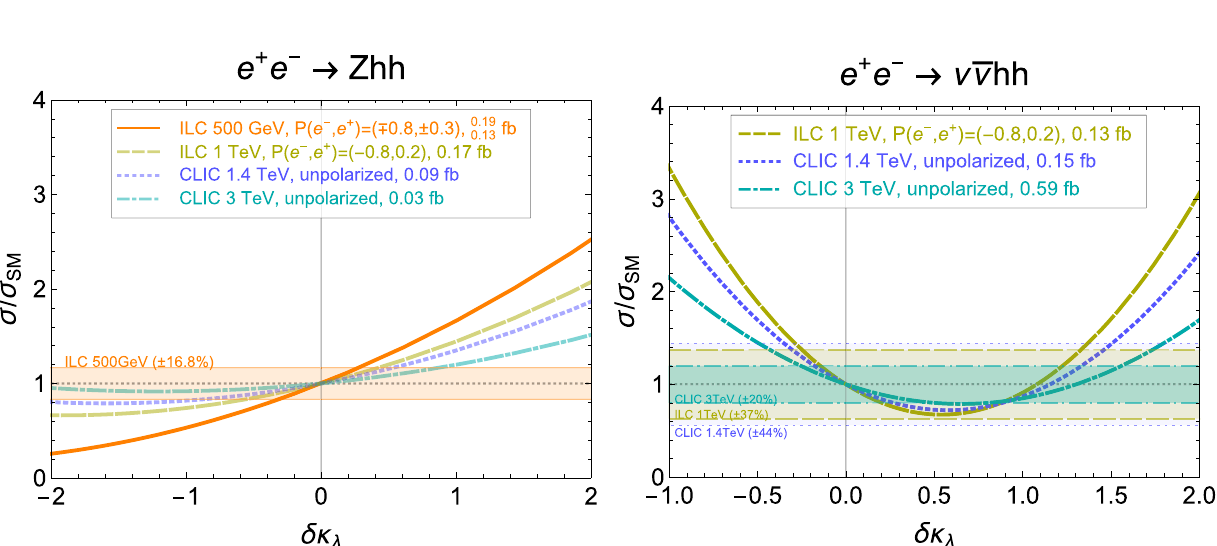
Fig. 2 Higgs-strahlung (left) and WBF production (right) of a pair of SM Higgs bosons as a function of λ hhh at the ILC and CLIC [66]. It should be noted that the experimental precision on the total cross section indicated by the horizontal bands is valid only for the SM